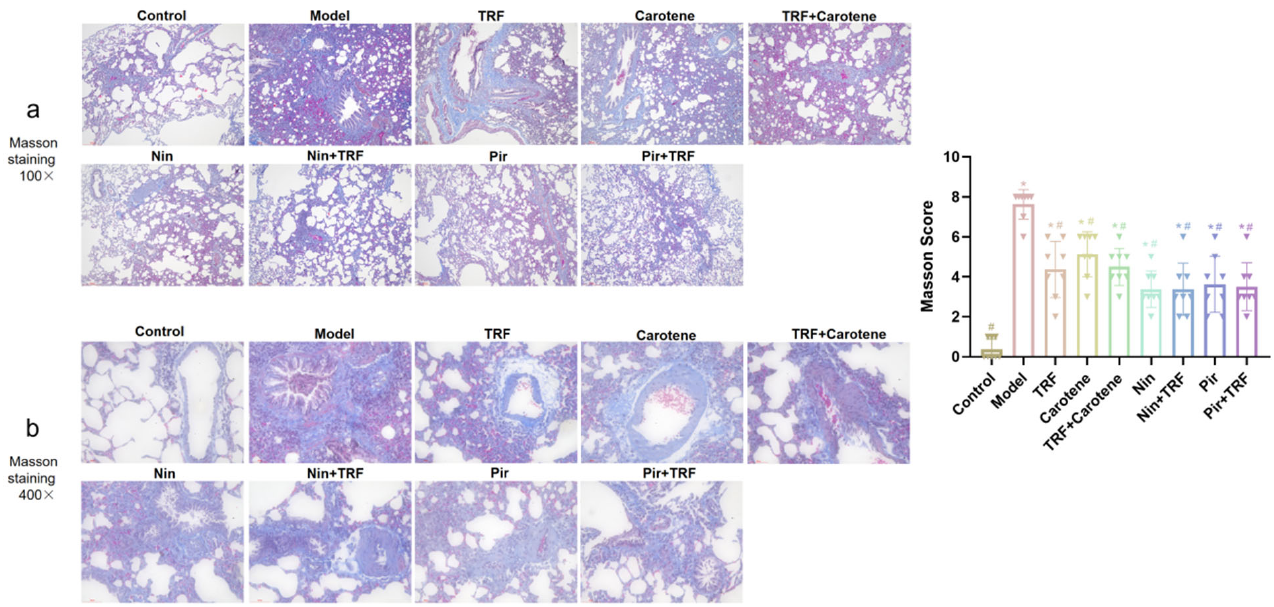
Figure 6. Effects on lung histopathological changes of TRF in Masson’s Trichrome stained specimens: Lungs from the different groups of rats were collected, and 4- µ m thick sections were prepared and used for the assessment of tissue injury; ( a ) original magnification 100 × ; ( b ) original magnification 400 × ; n = 8. Note: * represents p < 0.05 in comparison to the control group; # represents p < 0.05 in comparison to the model group.